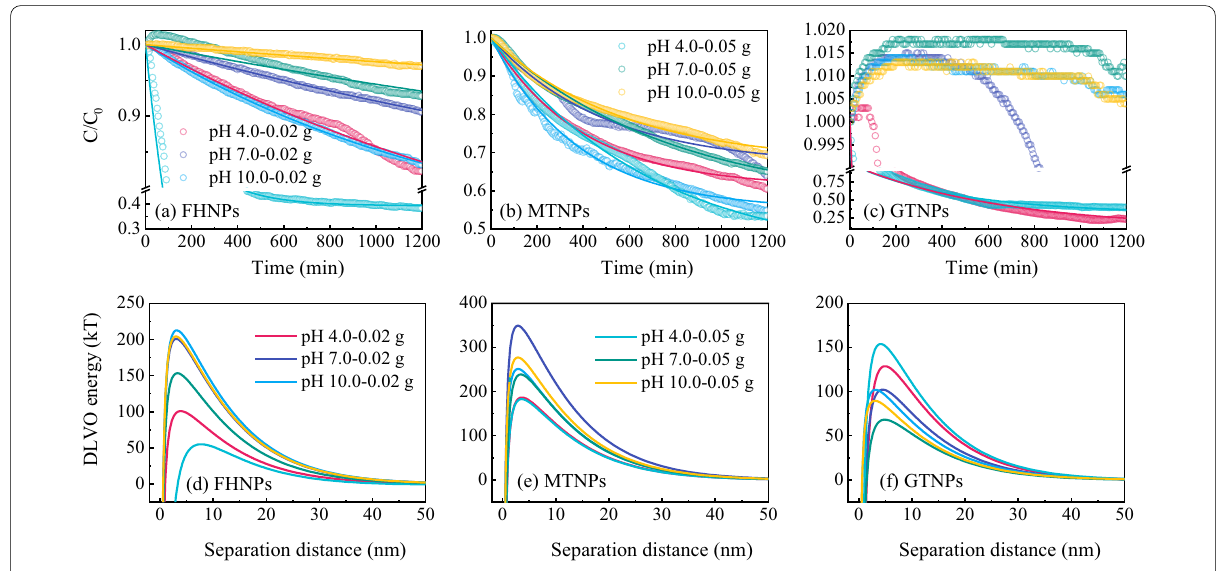
Fig. 2 Settling kinetics ( a – c , symbols indicate observed data points and lines indicate simulation fitting) and DLVO energies ( d – f ) of the BCNPs-IMNPs with varying iron mineral contents and